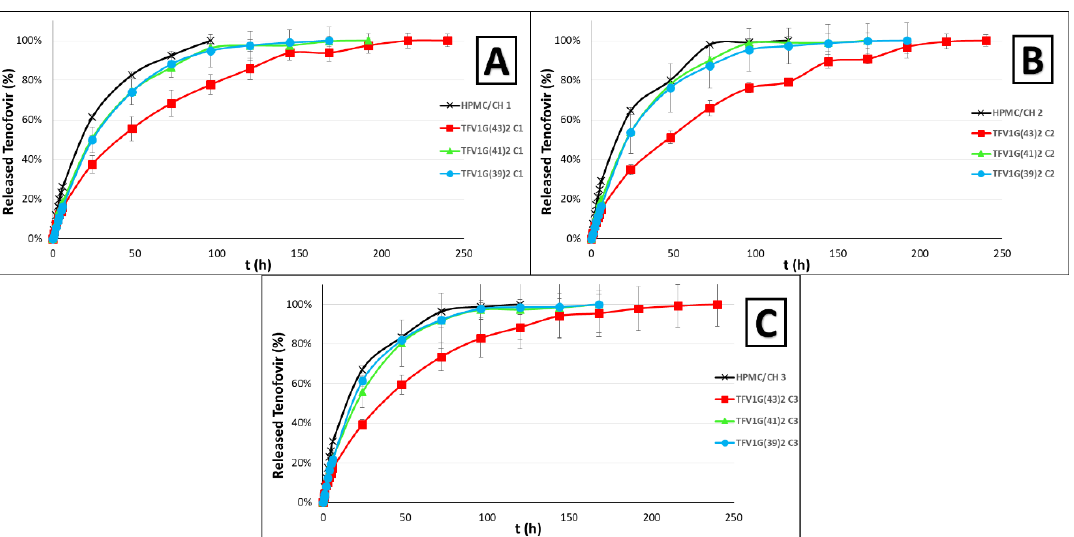
Figure 10. TFV release profiles obtained from batches containing TFV/Gelucire® (in a ratio of 1:2) granules in HPMC/CH matrices with equal ratios of both polymers ( A ); more HPMC than CH ( B ); and more CH than HPMC ( C ). All are compared with standard formulations of HPMC/CH [16].